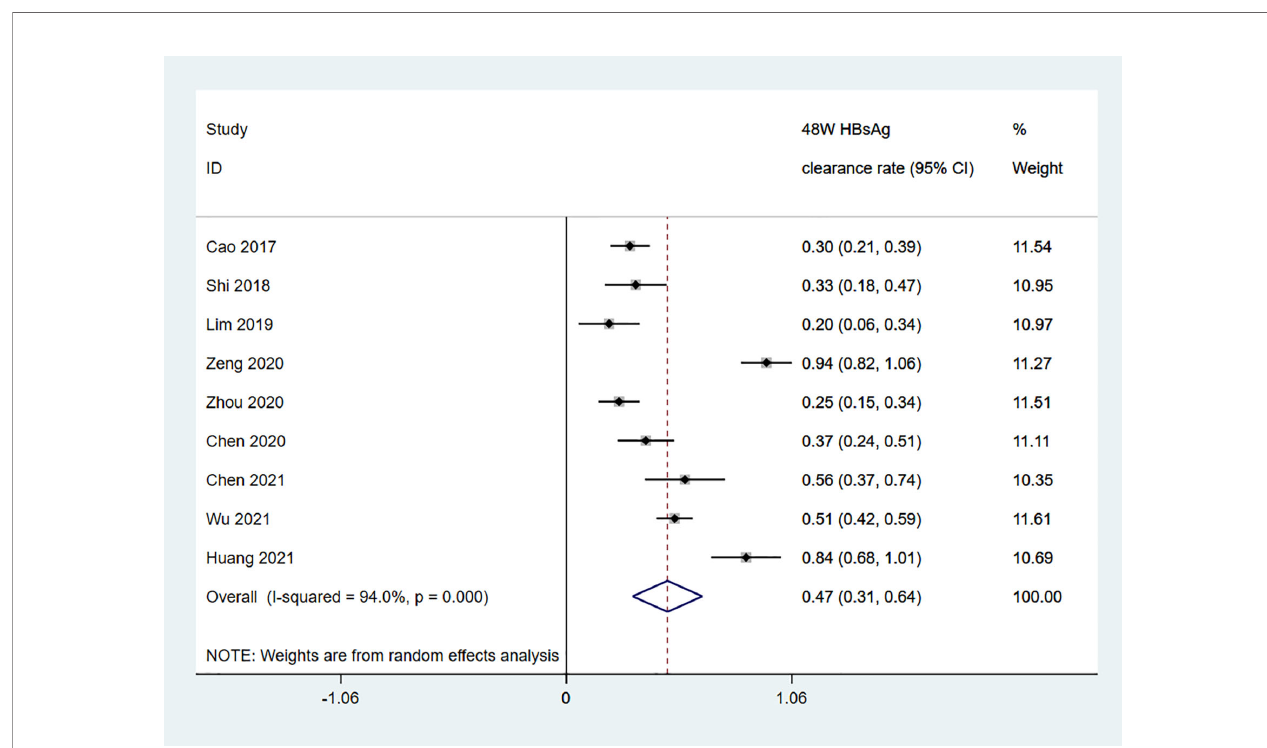
FIGURE 2 | Meta-analysis of the pooled HBsAg clearance rate among IHCs after 48-W Peg-IFN